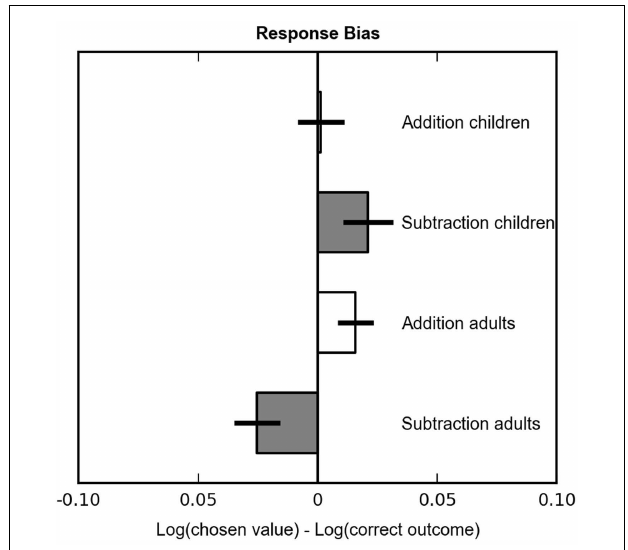
FIGURE 5 | Mean response bias for children and adults, defined as the difference between the chosen value and the correct outcome, both expressed on a log scale . A negative bias indicates underestimation, and a positive bias indicates overestimation.